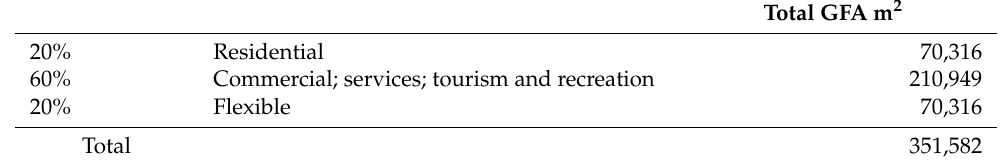
Table 3. Admitted intended uses.